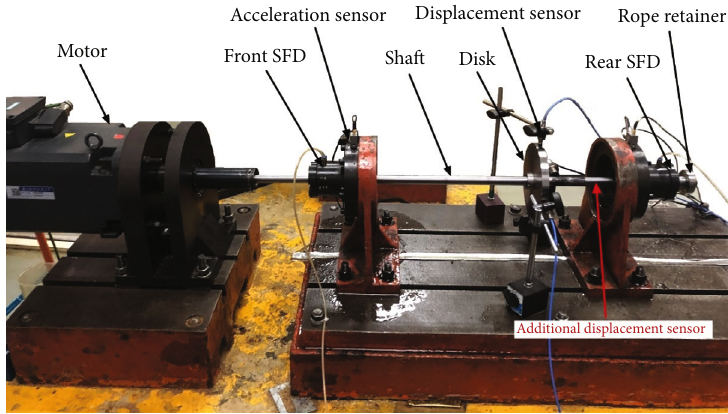
Figure 11: Physical drawing of rotor